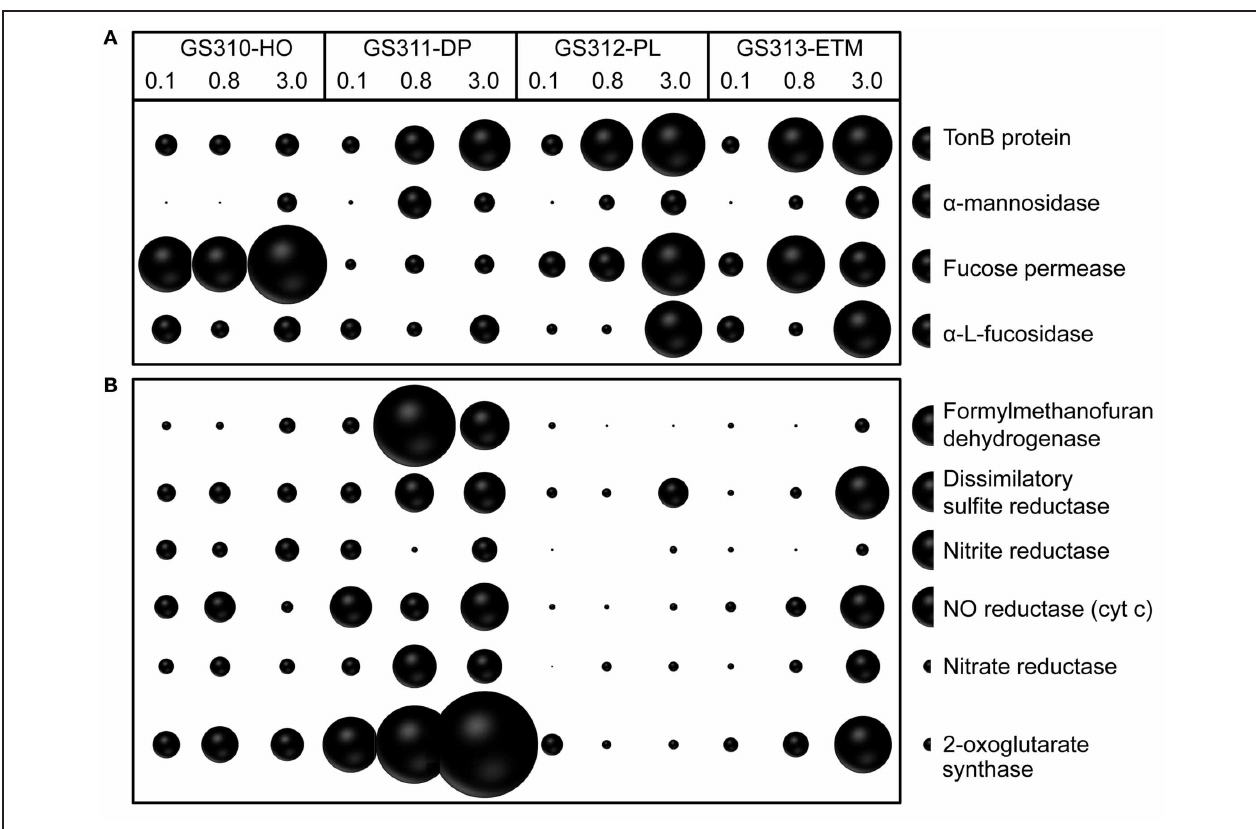
EC:1.7.99.7); nitrate reductase (EC:1.7.99.4); and 2-oxoglutarate synthase (EC:1.2.7.3). Abundance for a functional gene category was calculated as the number of hits to a given category normalized by average bacterial genome equivalents in the corresponding metagenome. Abundance values are shown by bubble width for each size fraction in each sample. Half-bubbles to the right of each row show the scale and correspond to 1 gene per effective bacterial genome equivalent. Sample names are encoded as described in the legend for Figure 3